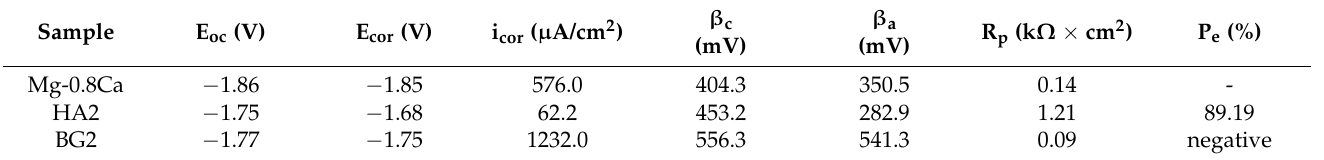
Table 3. The main parameters of the electrochemical corrosion process in